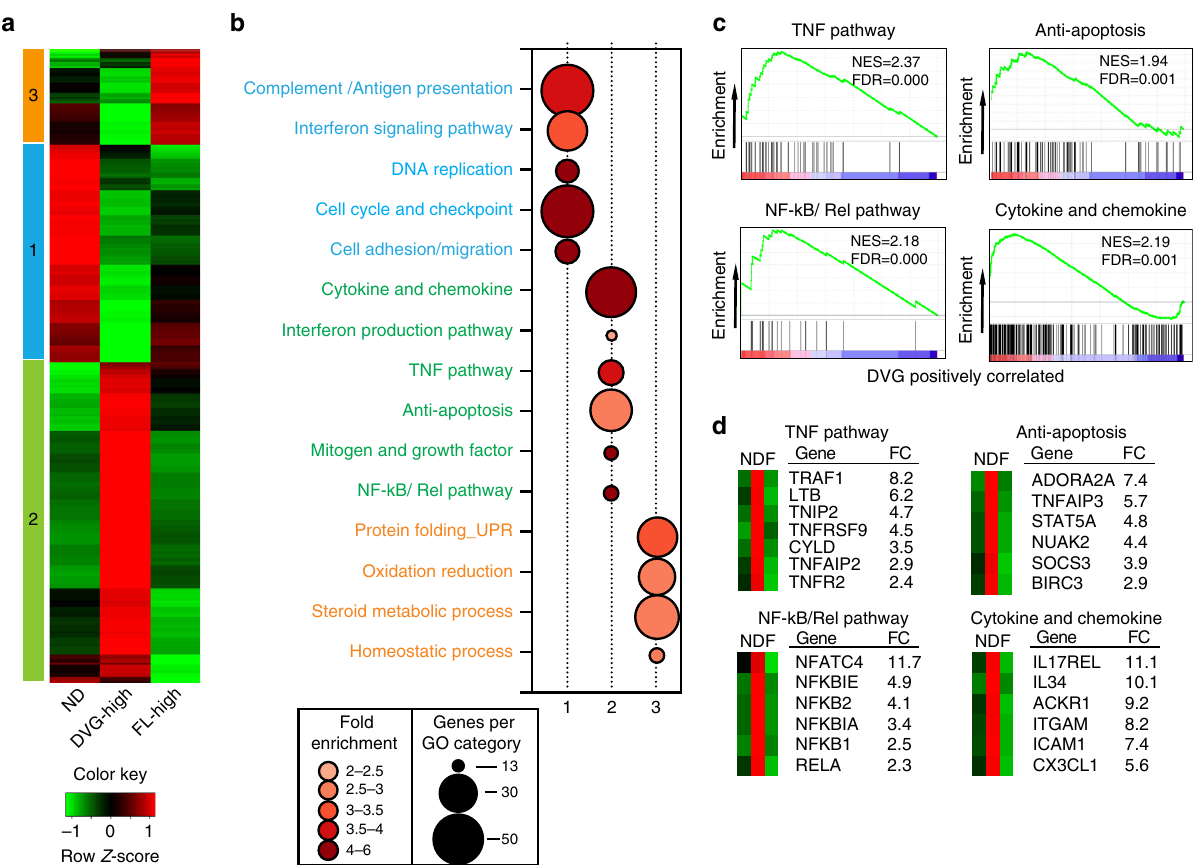
Fig. 4 Transcriptional pro fi ling of cells sorted based on DVG and FL-gSeV abundance identi fi ed distinct pro-survival pathways in DVG-high cells. a Hierarchical clustering and heatmap representation of 1800 genes differentially regulated among ND, FL-high, and DVG-high populations sorted from SeV HD-infected A549 cells at 24 h post infection. Color based on row Z -score. Three clusters of distinctly upregulated genes in each of the sorted sub-populations are indicated. b Bubble chart showing Gene Ontology (GO) enrichment analysis. Bubble size indicates the number of genes associated with each term. Bubble color intensity indicates fold enrichment of GO terms overrepresented in that cluster of genes. Pathways upregulated in each cluster were color-coded as blue (Cluster 1), green (Cluster 2) and orange (Cluster 3). c GSEA enrichment plots for four selected pathways differentially regulated in the DVG-high cells compared with others. Normalized enrichment scores (NES) and false discovery rate (FDR) are indicated. d Selected genes from each GSEA signature panel shown in c . Average fold change (FC) between DVG-high and FL-high cells is shown. N = ND, D = DVG-high, and F = FL-high in the mini-heatmaps shown in the left side of each graph. See also Supplementary Fig. doses tested (Fig. 5h, i). Taken together, these results suggest that